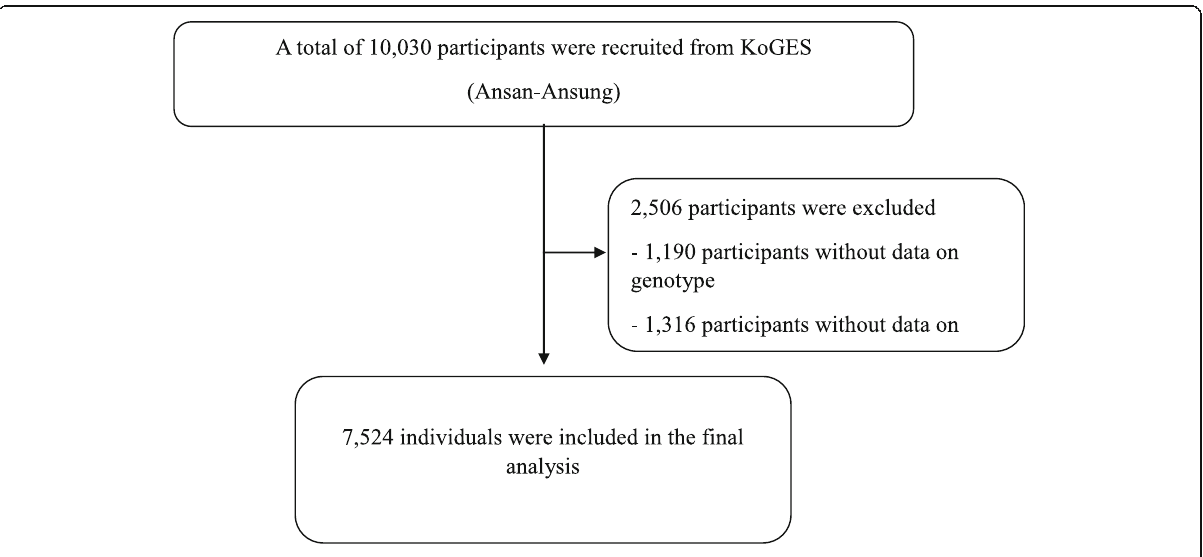
Fig. 2 Flowchart showing the final selection in cohort B. KOGES, The Korean Genome and Epidemiology